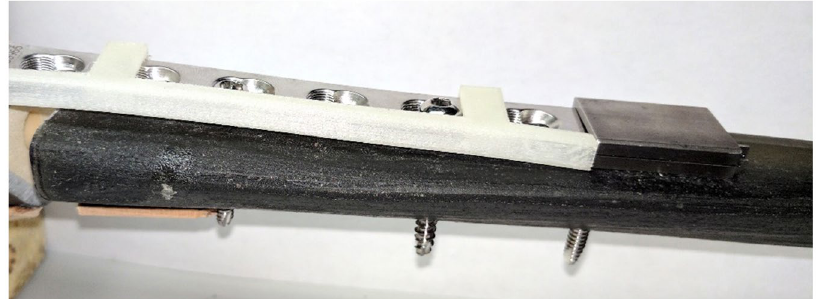
Figure 6. Photo of prototype pin